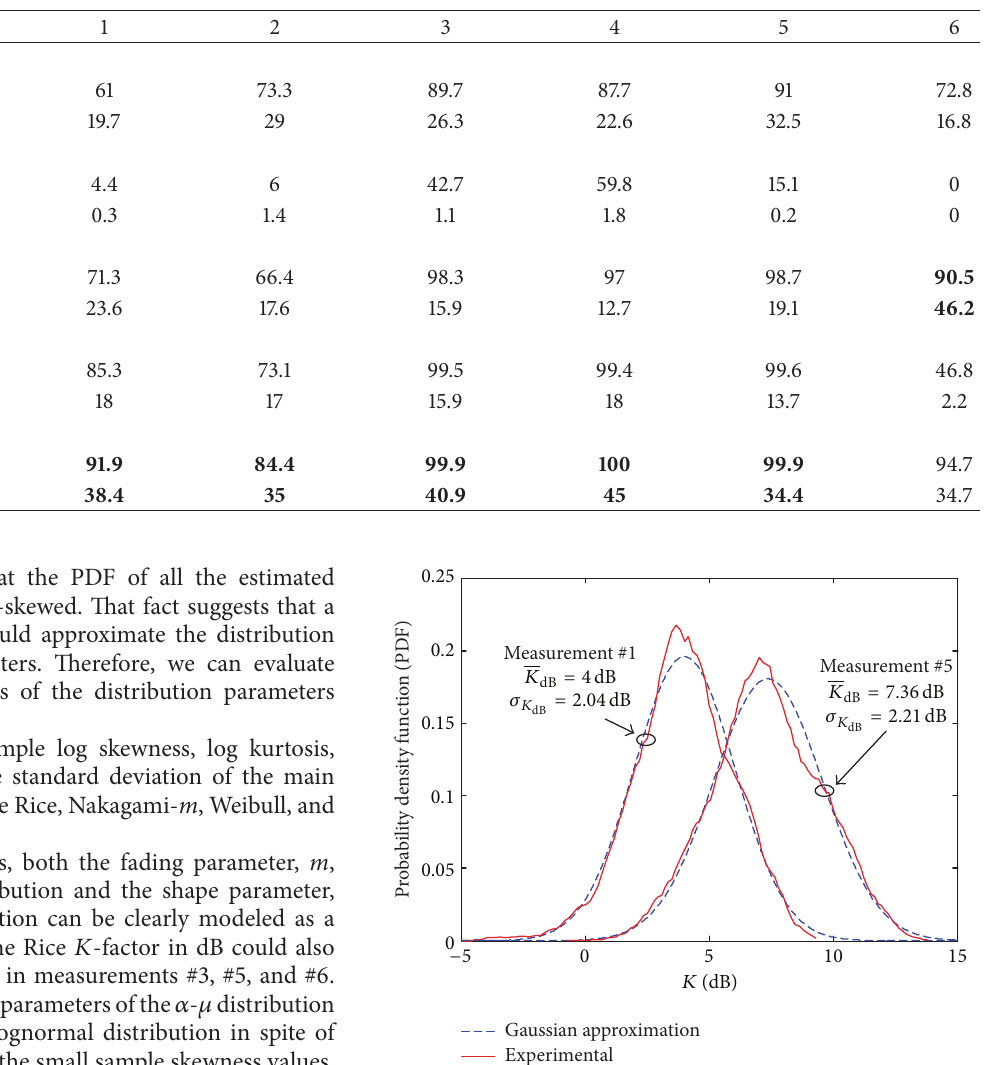
Table 3: Best-fit distributions percentages and Kolmogorov-Smirnov test accomplishment percentage for a confidence interval of 5%.